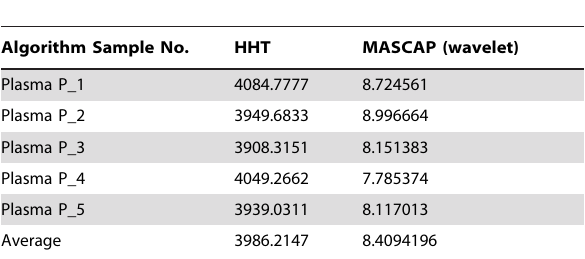
Table 3. CPU time of different approach (in seconds).